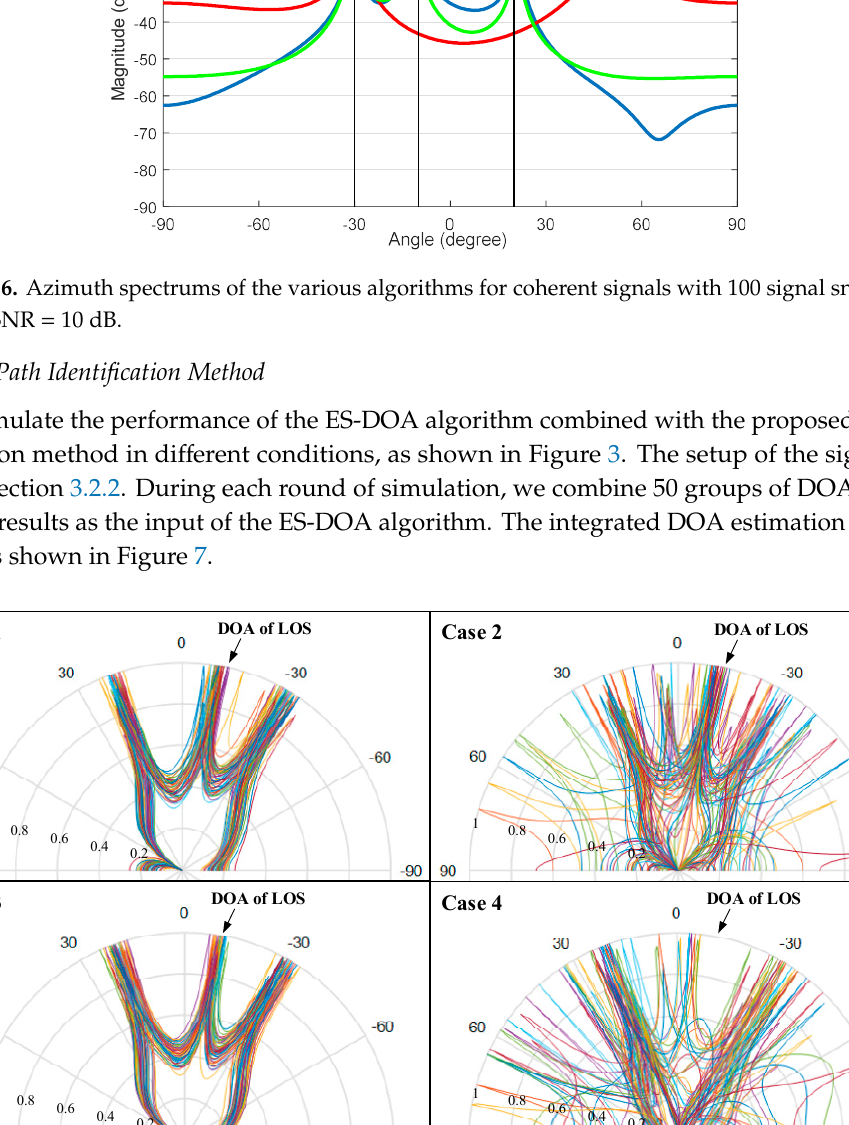
Figure 6. Azimuth spectrums of the various algorithms for coherent signals with 100 signal snapshots when SNR = 10 dB.